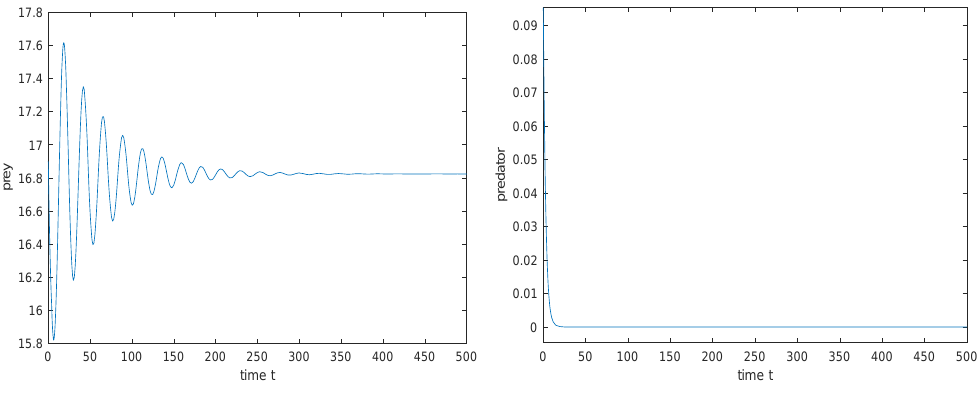
Figure 13. τ = 5 ∈ [ 0, τ ∗ ) = [ 0,5.5939 ) , E 2 is locally asymptotically stable. The initial value: ( φ 1 , φ 2 ) = ( 16.9,0.1 ) .